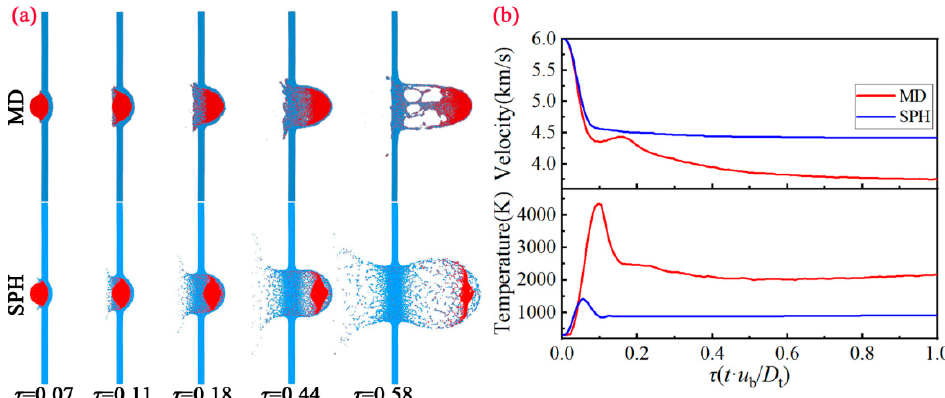
Figure 4. ( a ) Evolution of the debris cloud morphology between MD and SPH at different moments under u b = 6.0 km/s. ( b ) Comparison of the velocity and temperature variation with time between MD and SPH.